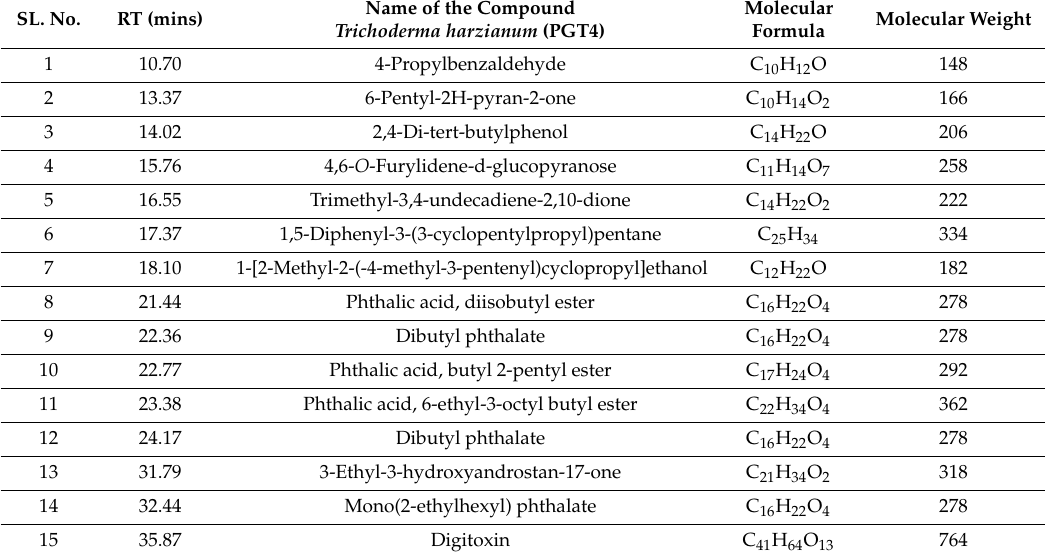
Table 2. List of compounds of Trichoderma harzianum (PGT4) detected by Gas Chromatography Mass Spectroscopy (GC-MS). RT—Retention